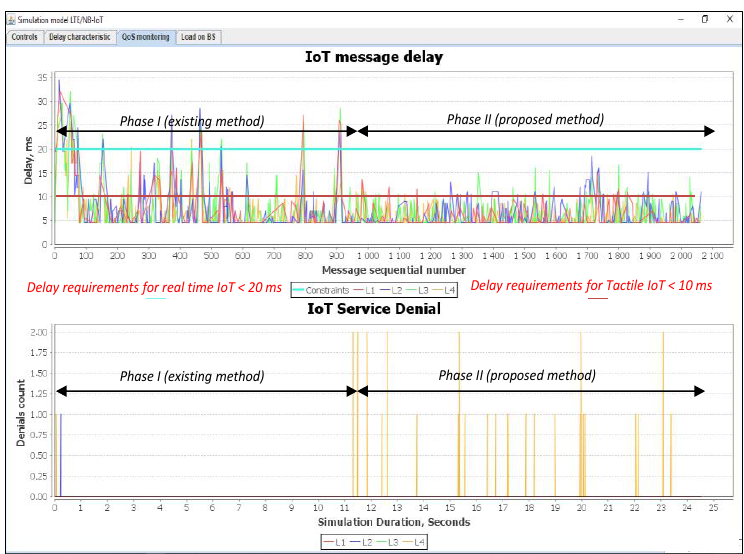
Figure 14. Delay and service denials for the requests from IoT devices (average load of IoT controller ρ = 18%).